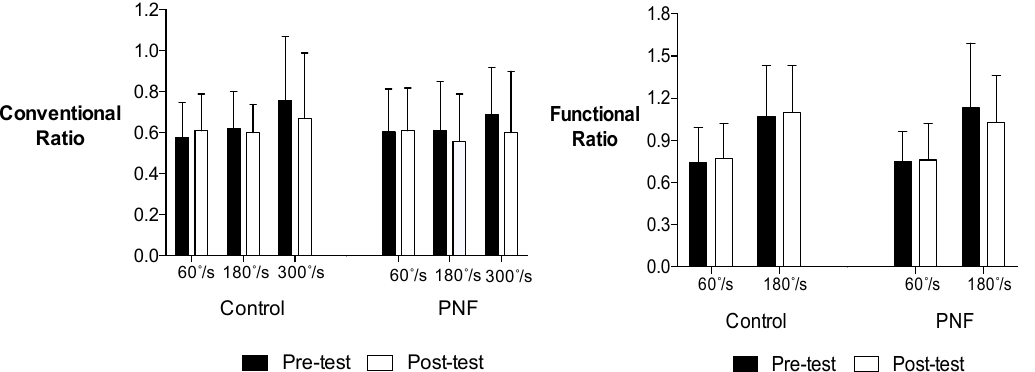
Figure 1. Mean values ± SD of the conventional and functional H:Q ratios for men.